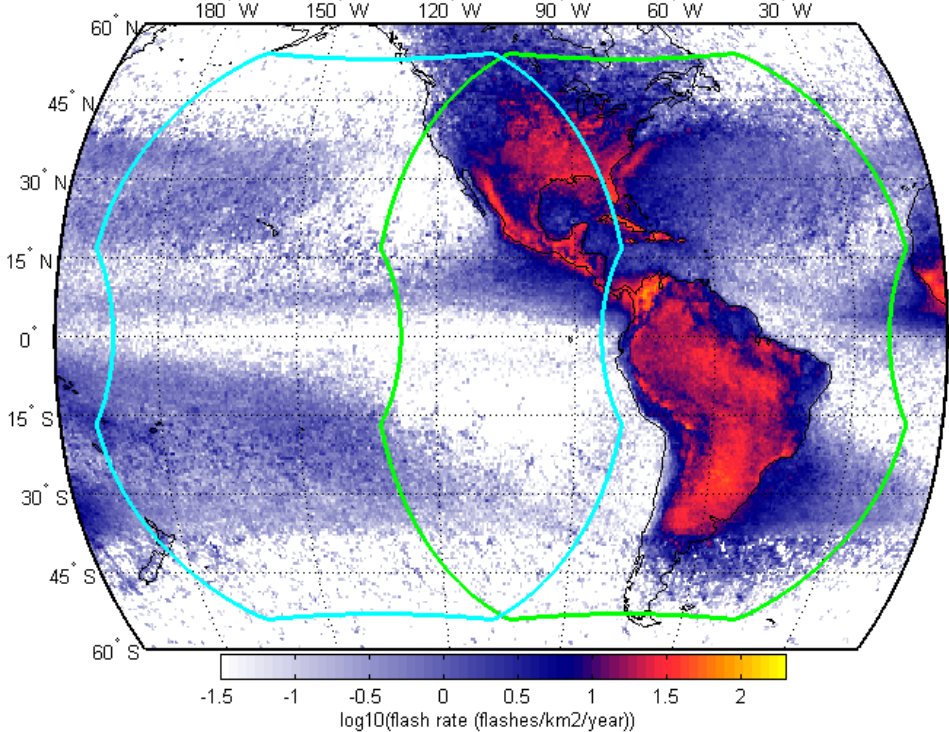
Figure 2. GLM coverage showing both GOES-16 (green) and GOES-17 (cyan) on map of lightning flash rate [24].